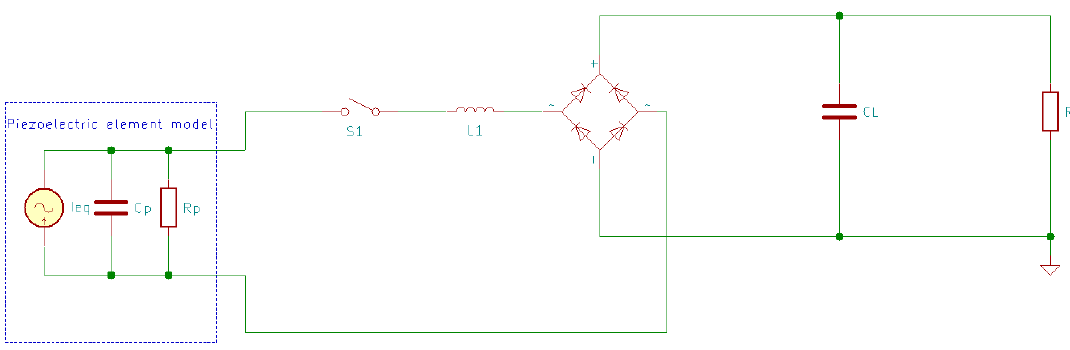
Figure 22. Self-powered series-SSHI energy harvesting circuit. In Figures 21 and 22, the diodes are 1N4004 model, 𝑇 (cid:2869) and 𝑇 (cid:2871) are TIP32C, 𝑇 (cid:2870) and 𝑇 (cid:2872) are TIP31C, 𝐿 (cid:2869) has 120 mH and 97 Ω , 𝐶 (cid:2869) and 𝐶 (cid:2870) are 23 nF capacitors and 𝐶 (cid:3013) has 47 µF [169]. For the self-powered series-SSHI, a current flowing through the circuit is generated by the piezoelectric transducer. When the output voltage across the piezoelectric transducer is increasing, 𝐶 (cid:2869) will be charged, while 𝑇 (cid:2869) and 𝑇 (cid:2870) are blocked, and when this voltage reaches the peak value, it starts